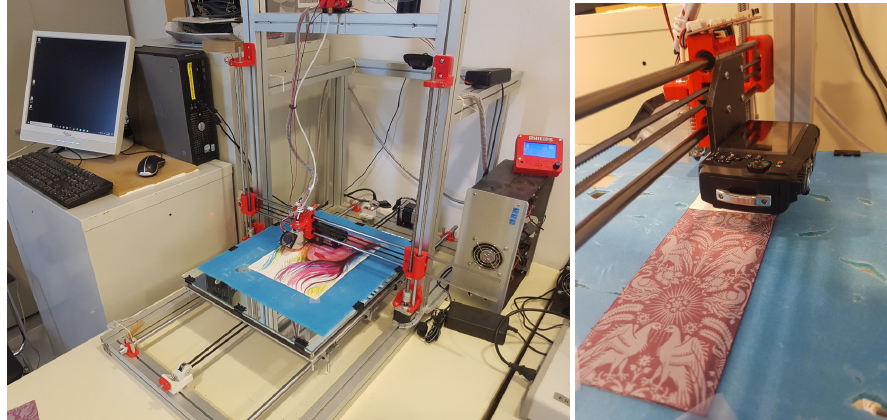
Figure 2. Prototype and close-up of the mounted